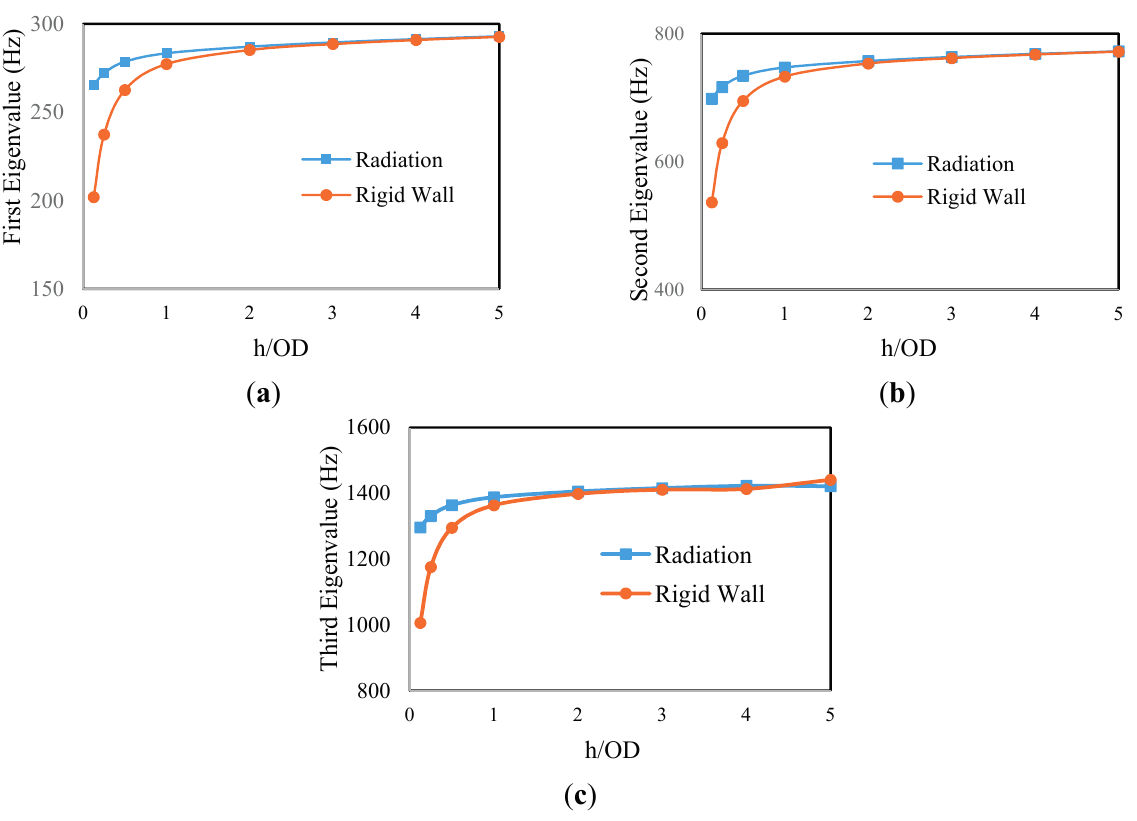
Figure 3. Evolution of the pipe’s eigenvalues: ( a ) first eigenvalue, ( b ) second eigenvalue, ( c ) third